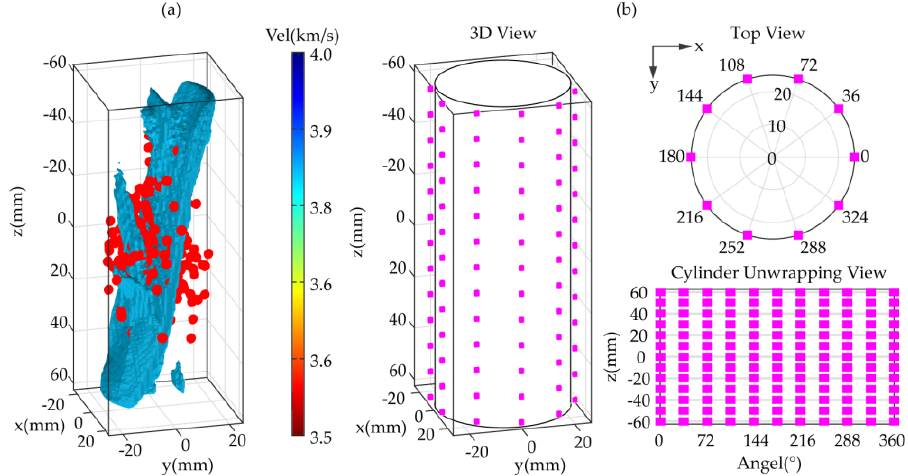
Figure 7. ( a ) 285 sources (red dot) set in the rock column; ( b ) 130 receivers (magenta square) placed around it under dense ray-coverage case and the observation geometry is shown in three views.